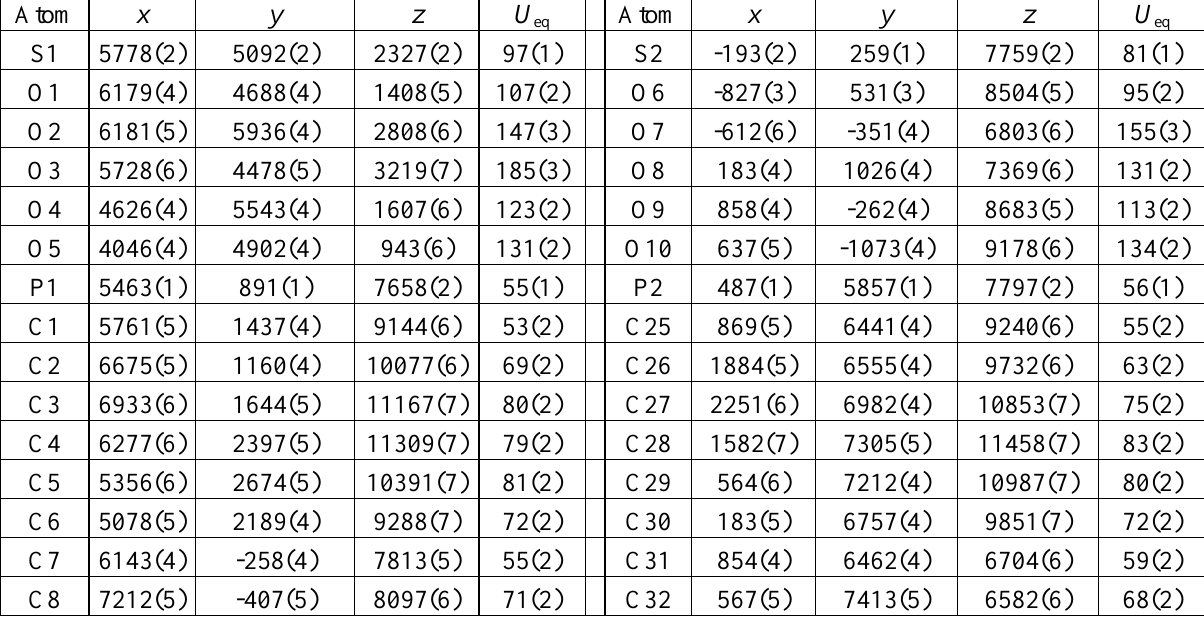
Table 1 . Atomic coordinates ( · 10 4 ) and equivalent isotropic displacement parameters (Å 2 · 10 3 ) for ( 4 ). U is defined as one third of the trace of the orthogonalized U eq